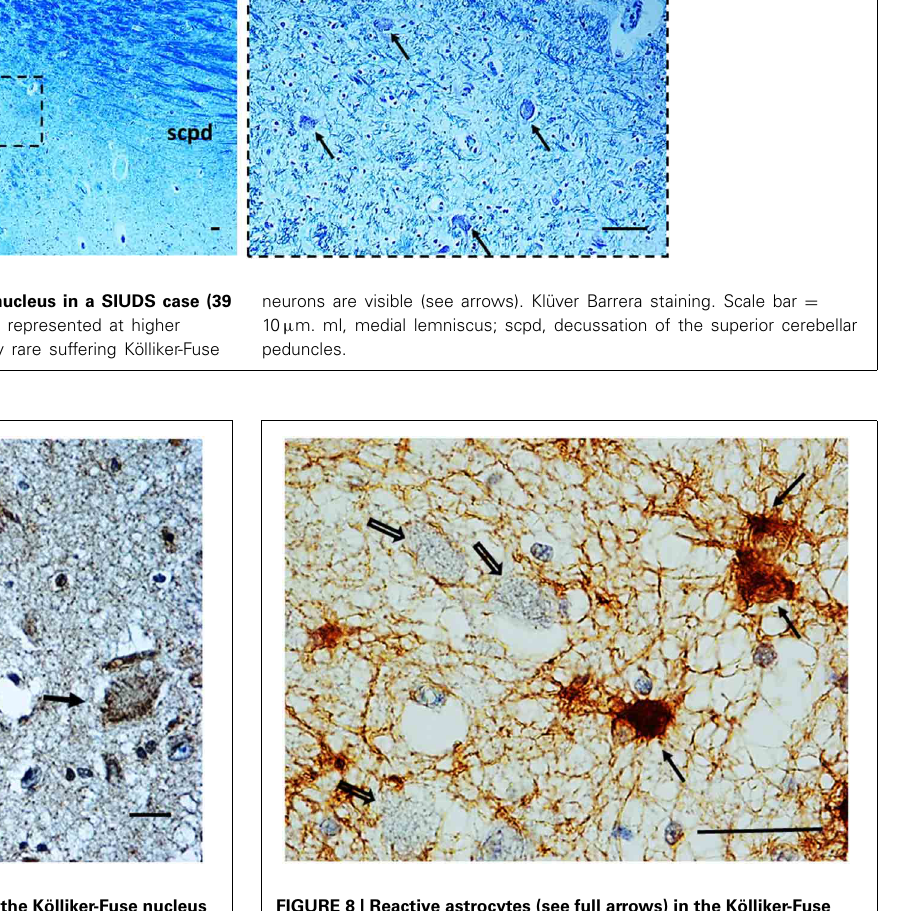
FIGURE 7 | BDNF weak immunopositivity of the Kölliker-Fuse nucleus in a SIUDS case (35 gestational weeks). Arrows indicate the large Kölliker-Fuse neurons. BDNF immunostaining. Scale bar = 10 µ m.